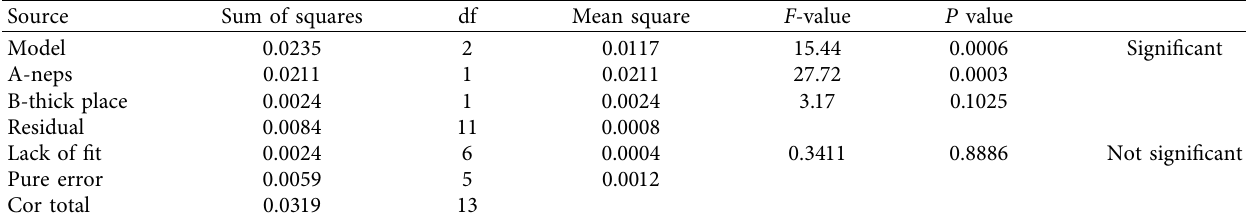
Table 5: Response 2: fabric cover by using ANOVA for the linear